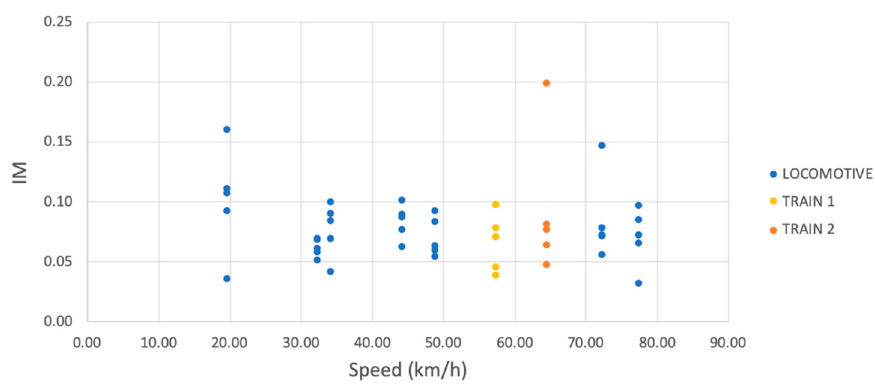
Figure 12. Impact factor (IM) calculated for all of the passages of all trains in all the points.